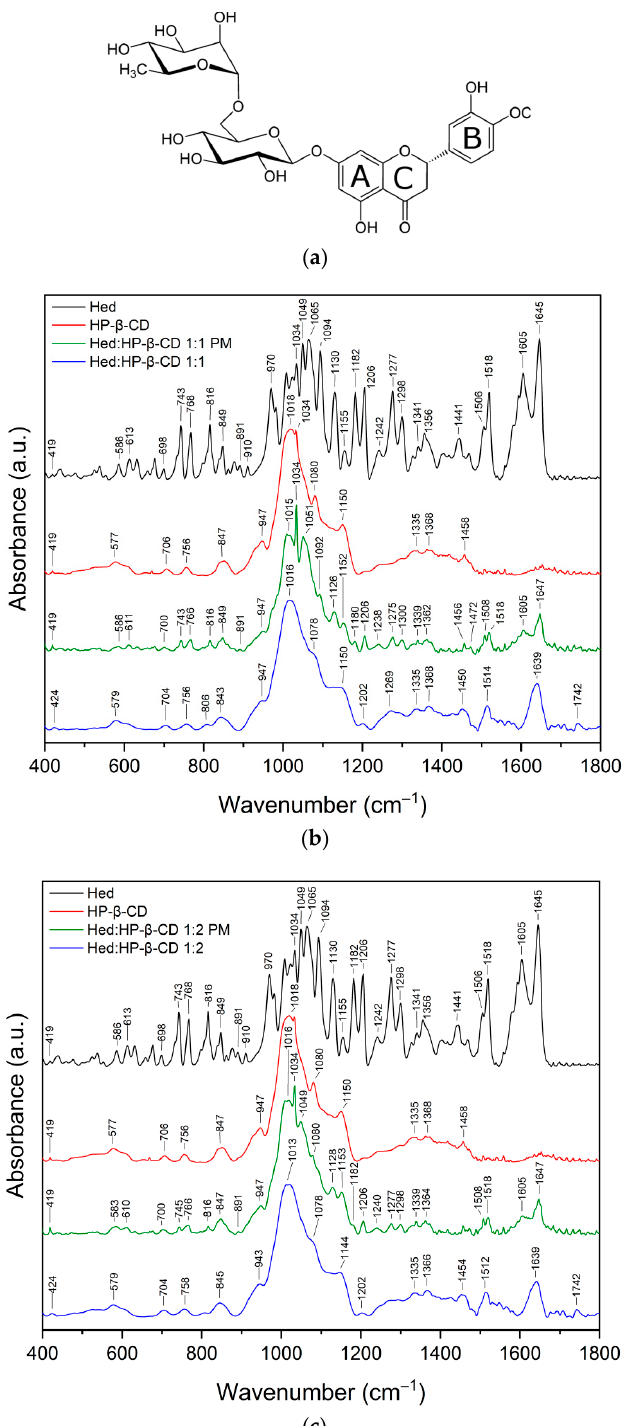
Figure 1. Structure of Hed ( a ). The results of FT-IR analysis of Hed (black), HP- β -CD (red), Hed/HP- β -CD 1:1 physical mixture (green), Hed/HP- β -CD 1:1 physical mixture (blue) ( b ), and Hed (black), HP- β -CD (red), Hed/HP- β -CD 1:2 physical mixture (green), Hed/HP- β -CD 1:2 physical mixture (blue) ( c ); range 400–1800 cm –1 .